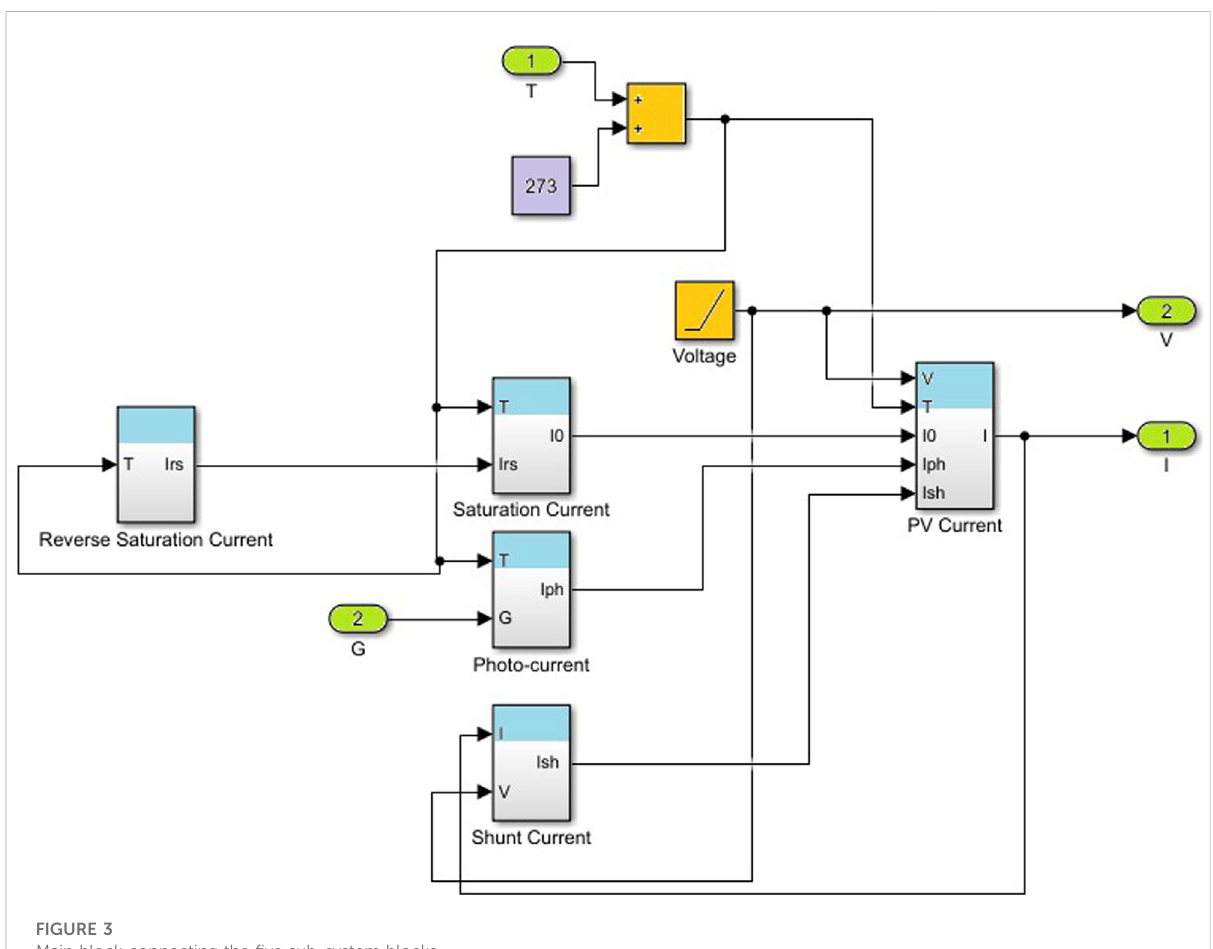
FIGURE 3 Main block connecting the fi ve sub-system